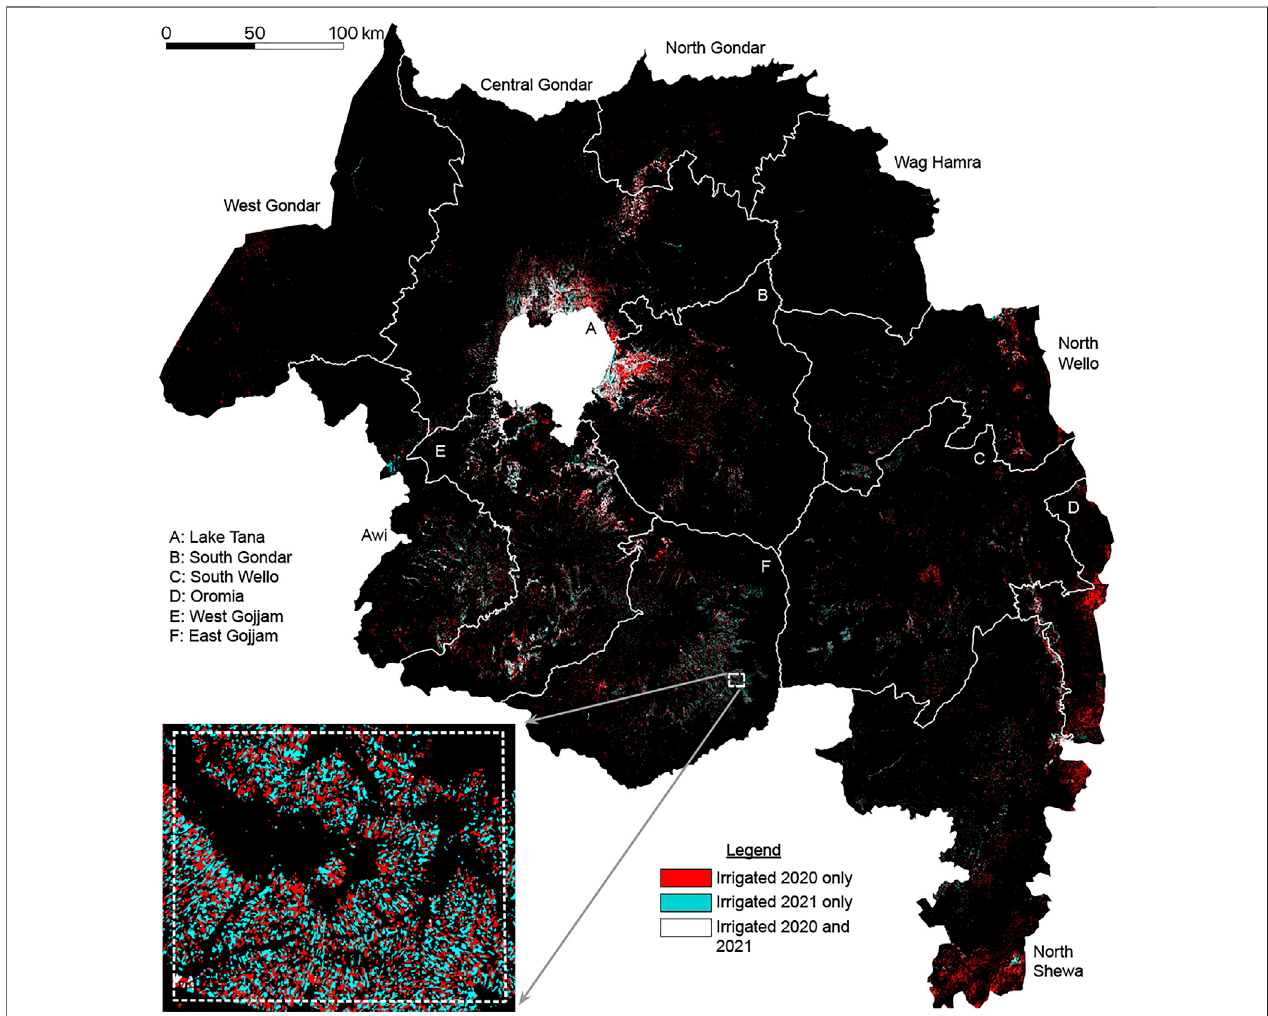
FIGURE 8 | Bitemporal irrigation map for Amhara. Figure inset contains example predictions around Choke Mountain displaying interannual irrigation patterns. A predominance of red indicates that many parts of Amhara contain irrigation detected in 2020 but not in 2021.